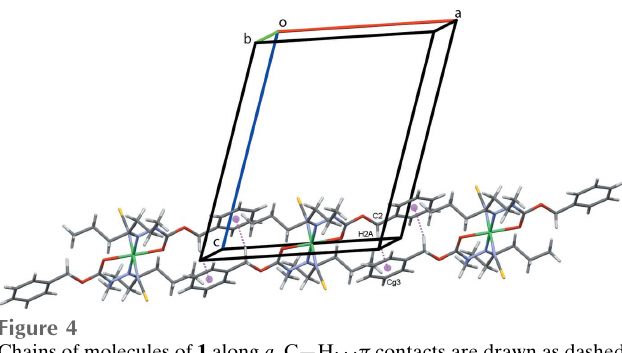
Figure 4 Chains of molecules of 1 along a . C—H (cid:2)(cid:2)(cid:2) (cid:2) contacts are drawn as dashed magenta lines with the centroids ( Cg ) of the C3–C8 rings shown as magenta spheres.